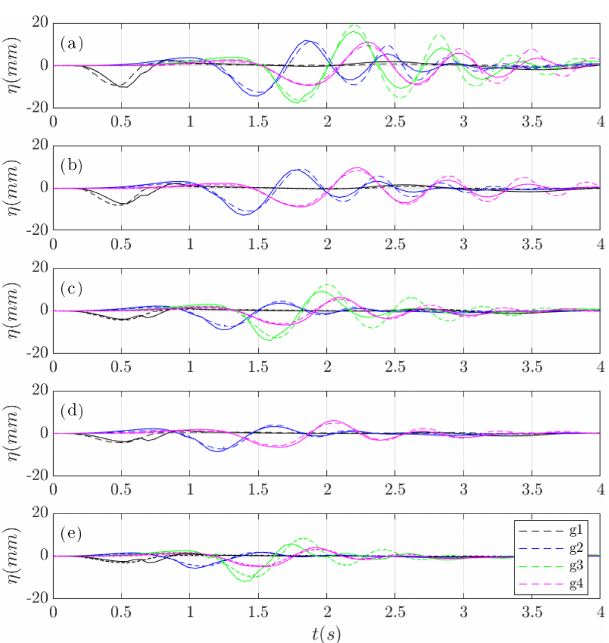
Figure 9. Comparison of data and numerical solution time series at wave gauges (dashed) for the cases (a) d = 80mm, (b) d = 100mm, (c) d = 140mm, (d) d = 149mm, and (e) d =